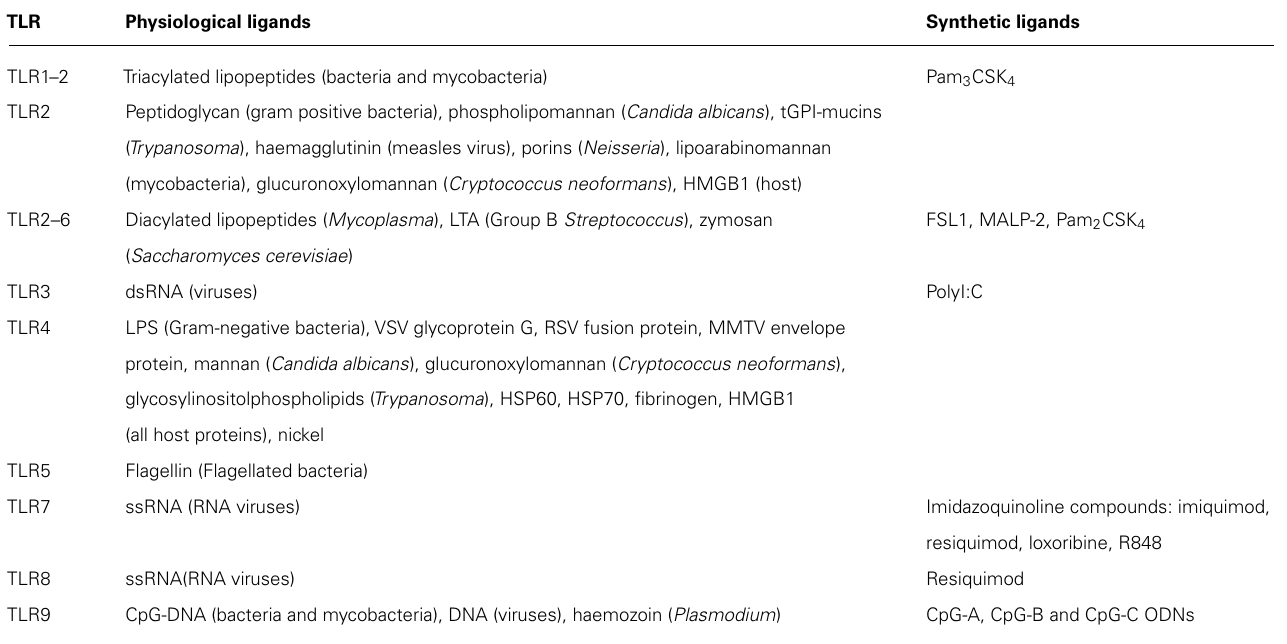
Table 1 |The mainTLR ligands (adapted fromAkira etal., 2006; Lee etal., 2012). TLR Physiological